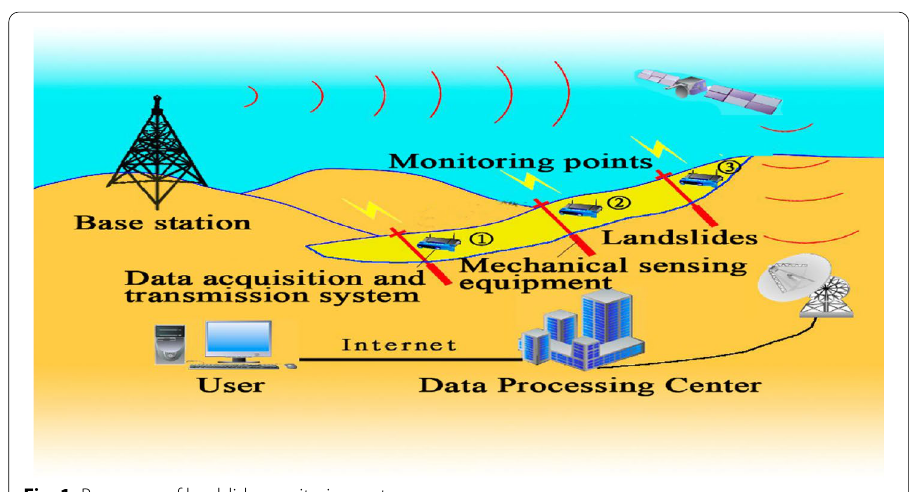
Fig. 1 Panorama of landslide monitoring